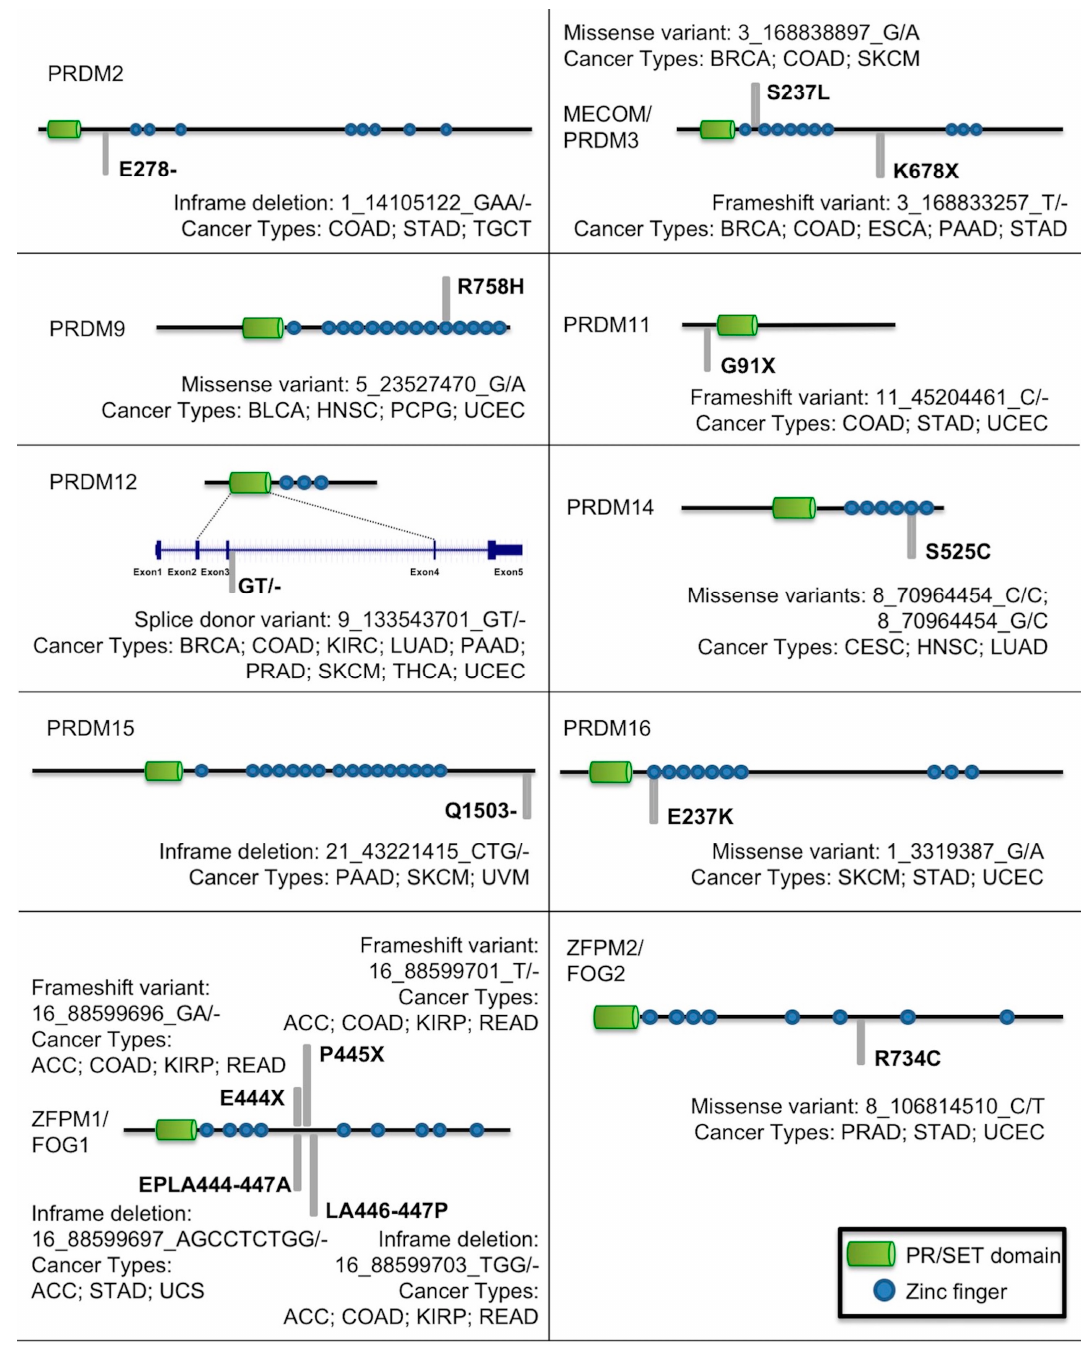
Figure 3. Mutations in PRDM genes recurrent in more than three tumor